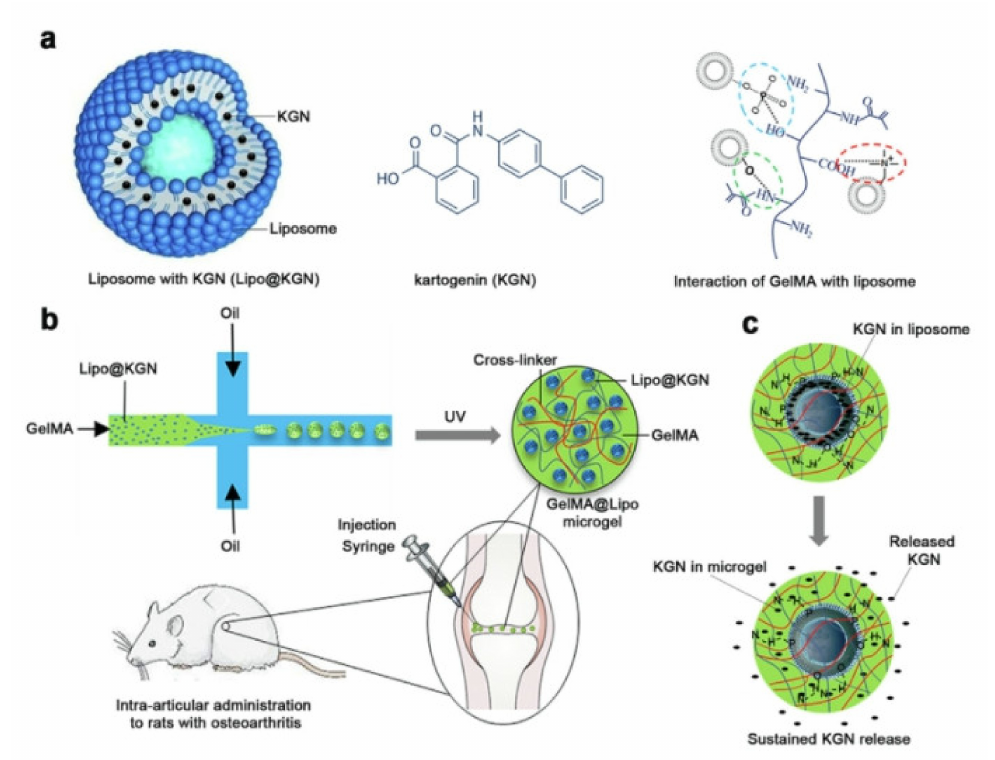
Figure 4. ( a ) Liposome loaded with kartogenin (KGN), chemical structure of KGN, and hy- drogen bonds between GelMA and liposomes (from left to right); ( b ) preparation process and intra-articular injection of gelatin methacryloyl microgels incorporating KGN-loaded liposomes (GelMA@Lipo@KGN) to mice with OA; ( c ) sustained KGN release by overcoming the dual obstacles of lipid membrane and hydrogel matrix network. Reprinted with permission from Yang et al, Chem. Eng. J, published by Elsevier,